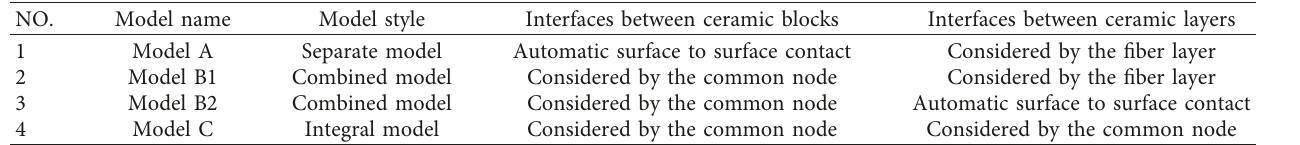
Figure 9: Integral model of the FC target. Table 4: Various finite element model for FC